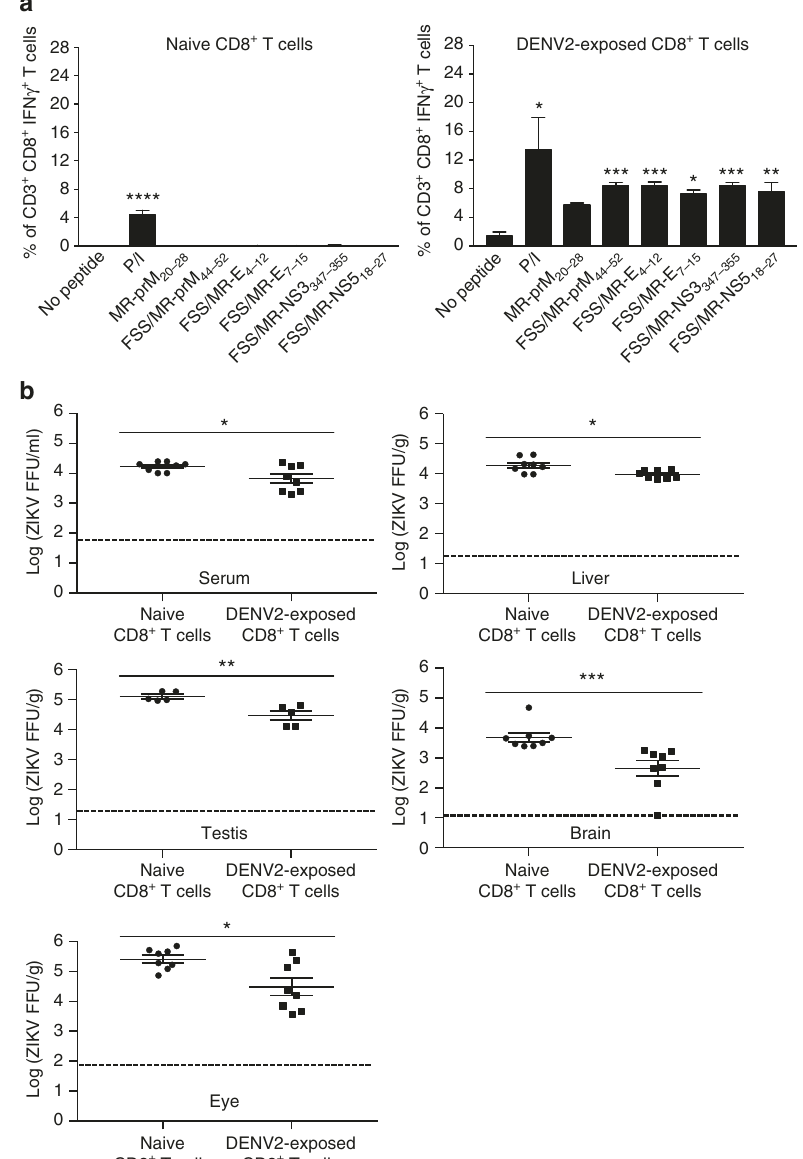
Fig. 3 Reduced ZIKV burden in Ifnar1 − / − mice adoptively transferred with DENV2-exposed CD8 + T cells. Naive (1 × 10 7 ) and DENV2-exposed CD8 + T cells (1 × 10 7 ) from Ifnar1 − / − mice were adoptively transferred to naive recipient Ifnar1 − / − mice. Three days post ZIKV challenge (1 × 10 4 FFU of ZIKV FSS13025, retro-orbital route), cross-reactive peptide-speci fi c CD8 + T cell responses ( a ) and ZIKV levels in sera and indicated organs ( b ) were detected by ICS assay and FFA, respectively. Data are pooled from two independent experiments ( n = 3 – 4 mice per group per experiment) and expressed as mean ± SEM. * p < 0.05, ** p < 0.01, *** p < 0.001,**** p < 0.0001. a A Kruskal – Wallis one-way ANOVA. b Two-tailed Mann – Whitney test. Supplementary Tables 1 and 2 provide exact values of n and